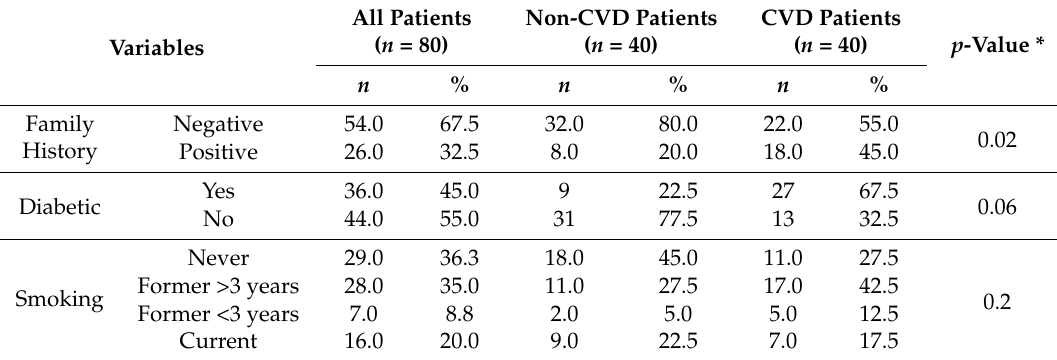
Table 3. Family and smoking history of the study